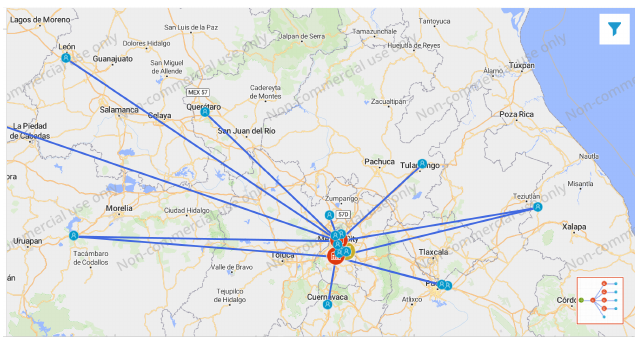
Figure 16. Supply Chain Network